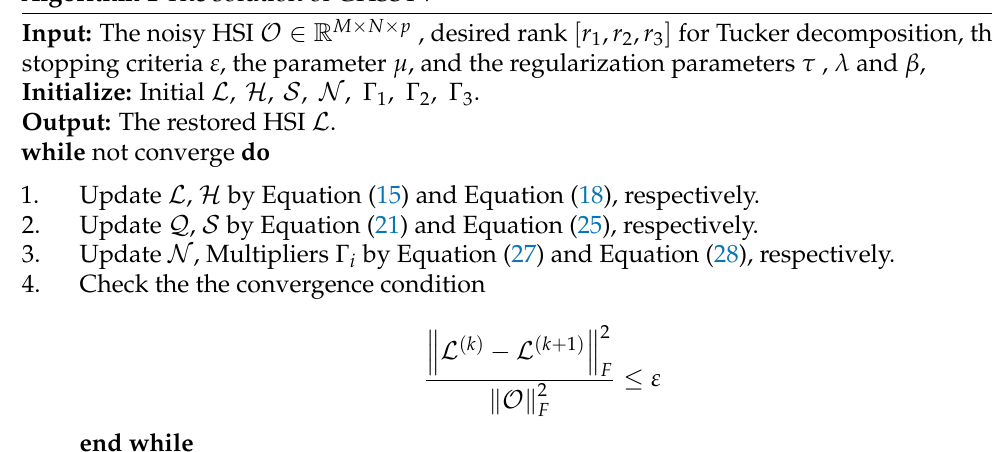
Algorithm 1 The solution of